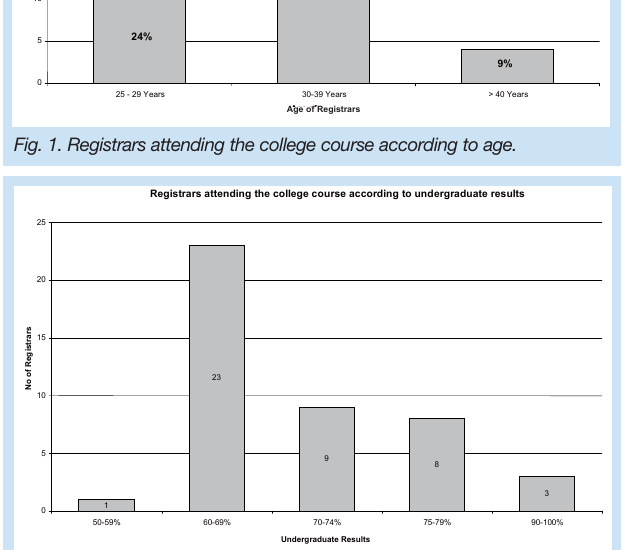
Fig.5.Yearsofpostgraduateexperience(includinginternship)beforeregistrarsappointment.Yearsofpostgraduateexperience(includinginternship) Fig. 5. Years of postgraduate experience (including internship) before regis- trar